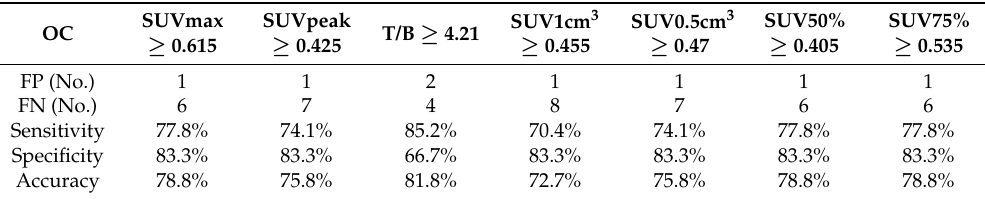
Figure 2. ROC curve for the parameters that differ significantly between negative and positive lesions. The curves are close to one another, but SUVmax has the best performance. Table 5. Optimal cut-offs and the corresponding false positive and false negative results, sensitivity (sens), specificity (spec) and accuracy. OC: optimal cutoff. No.: number of lesions, FP: false positive, FN: false negative .